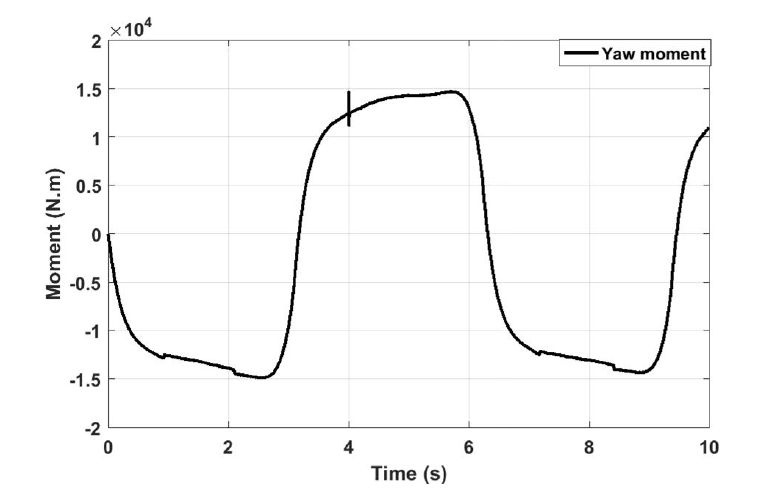
Figure 12. Input control of the